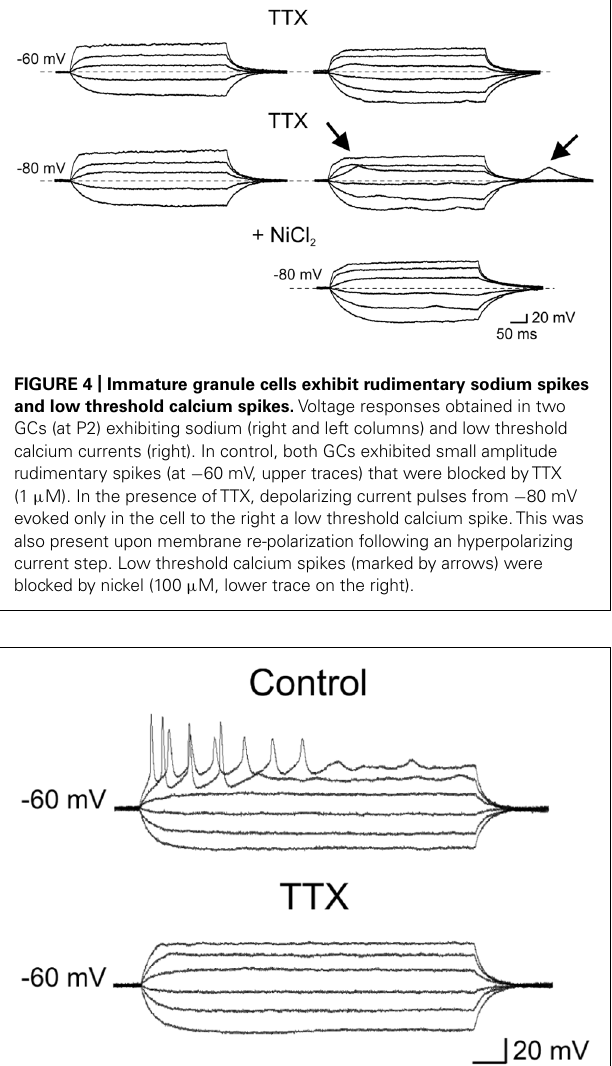
Thus, at P2, only a small percentage of Prox1-positive GCs